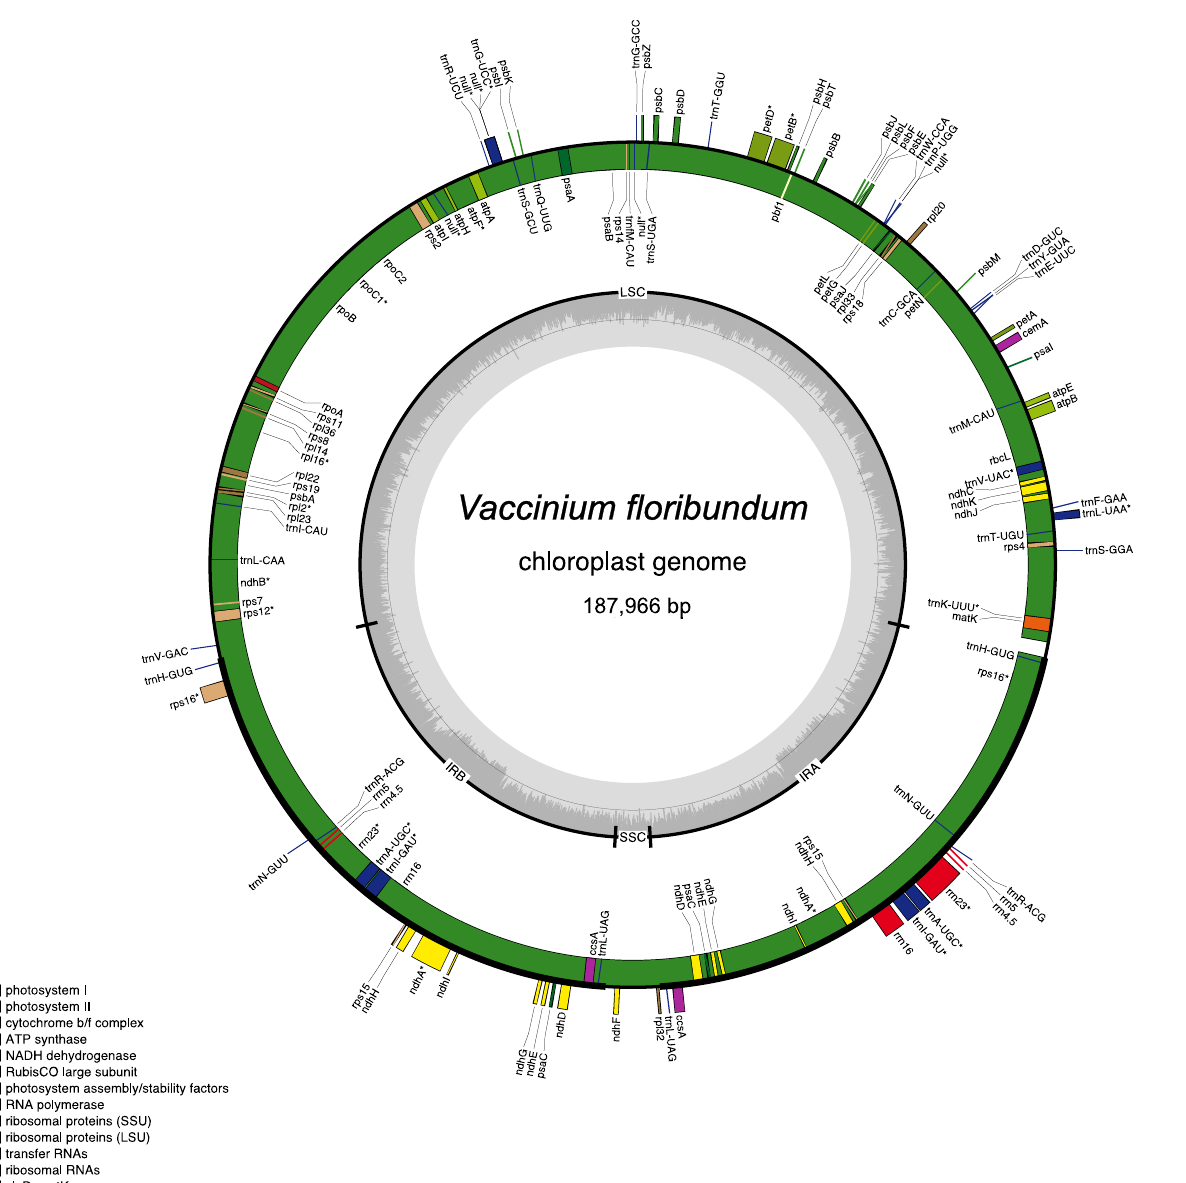
Figure 1. Cp genome map of V. floribundum . On the bottom left, the genes corresponding to the different functional groups are depicted with distinctive colors. Genes that are inside the circle are transcribed in a clockwise direction. Genes outside the circle are transcribed in a counterclockwise direction. The light grey line inside the circle represents the AT content, and the dark grey area illustrates the GC content. IRa/IRb, LSC, and SSC regions are shown by black lines surrounding the dark grey